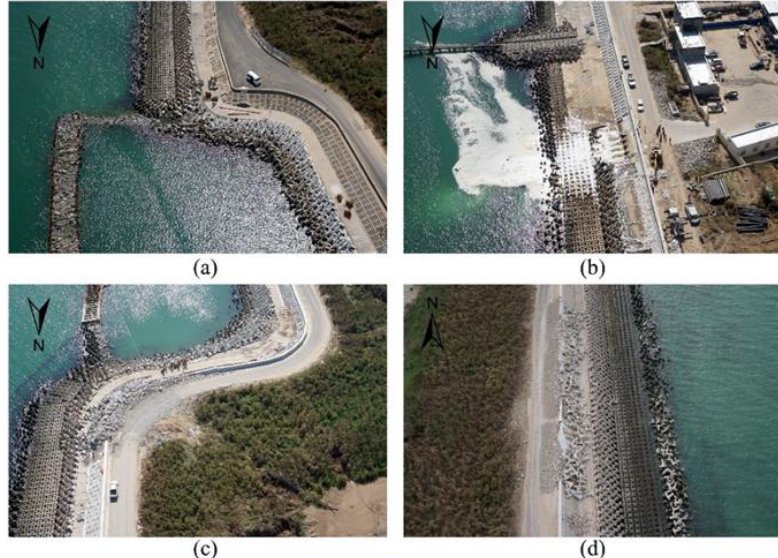
Figure 3. Aerial photos obtained by the unmanned aerial vehicle (UAV) in August 2019: ( a ) structures of Gudong Dam; ( b ) Gudong tide gauge station and drainage station built for draining water as a response to the waterlogged condition after Typhoon Lekima (Super Typhoon Lekima, International Code: 1909); ( c ) damage to the bending section at Gudong Dam caused by Typhoon Lekima; ( d ) damage to the straight section at Gudong Dam due to Typhoon Lekima.